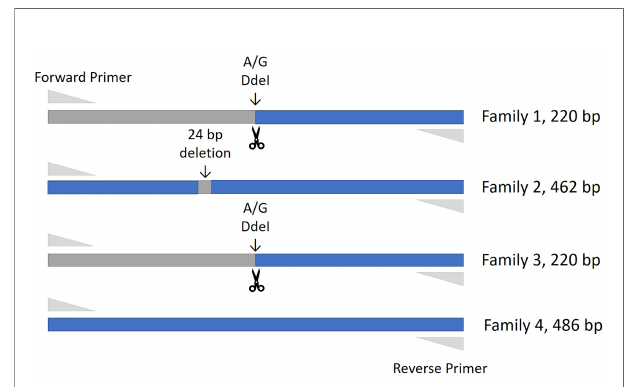
FIGURE 1 | Ampli fi cation fragment sizes obtained by the genotyping assay for each of the PTPRC families. The restriction site enzyme DdeI was used to cut the Bos taurus (Family 1 & Family 3) reference sequence at location 68,989. Neither the Family 2 nor Family 4 alleles are cut at this location, and these alleles are differentiated by the 24 bp deletion that is the main characteristic of the Family 2